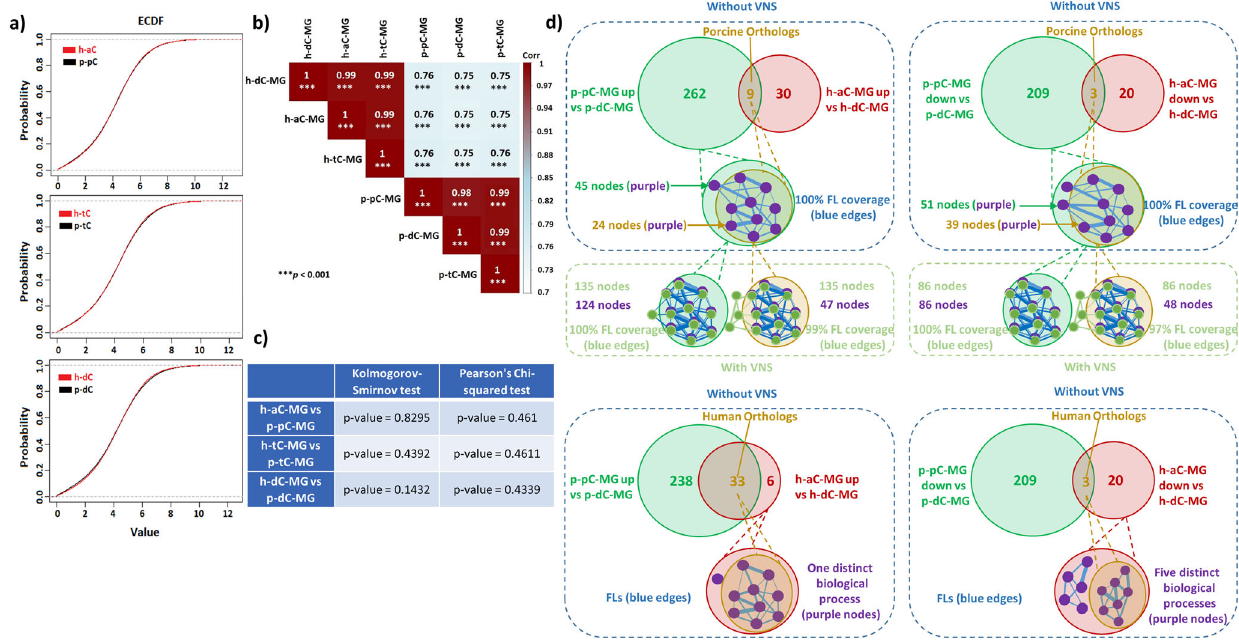
Fig. 2 Transcriptomic similarities of colonic myenteric ganglia between pig and human. Probability distributions of human-porcine regional datasets selected from the high-quality orthologous gene list between myenteric ganglia (MG) from porcine proximal, transverse and distal colon (p-pC, p-tC, p-dC) and in parallel from human ascending, transverse and descending colon (h-aC, h-tC, h-dC) a , Spearman ’ s Correlation b , and evaluation of goodness of fi t c . Color in b represents a correlation distribution from big (dark red) to small (light blue). Cartoon diagram showing regional differentially expressed gene (DEG) network matching between human and pig d . Gene Ontology Biological Processes terms (pathways) are shown as circles (nodes) that are connected with lines (edges) if the terms share many genes. Nodes are colored in purple (without VNS) and in light green (with VNS), and edges are sized on the basis of the number of genes shared by the connected pathways. FLs functional linkages, VNS vagal nerve stimulation, Up upregulated expression, Down downregulated